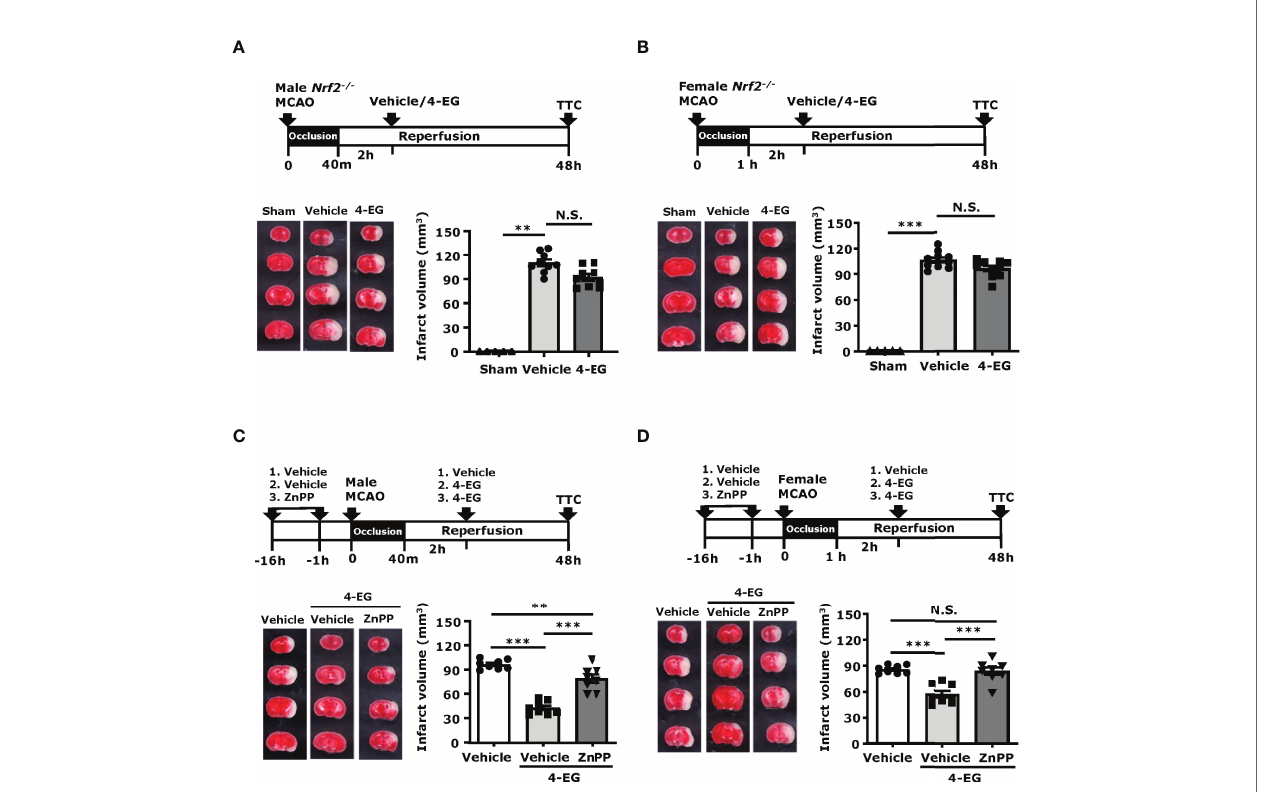
FIGURE 6 | Inhibition of Nrf2/HO-1 pathway reverses the protection effect of 4-EG in ischemic stroke. (A, B) Male and female Nrf2 − / − mice were subjected to sham or MCAO followed by vehicle or 4-EG (100 mg/kg) administration at 2 h post-reperfusion. At 48 h post-injury, mice were sacri fi ced, and the ischemic brains were harvested, sliced, and stained with TTC. (A) . The representative TTC-stained brain samples of sham, and vehicle- and 4-EG-treated male Nrf2 − / − MCAO mice are shown (left panel), and the infarct volumes of sham (n=5), and vehicle- and 4-EG-treated male Nrf2 − / − MCAO mice (n=9/group) were measured (right panel). ** p < 0.01 , N.S., no signi fi cant differences by the Kruskal – Wallis test. (B) The representative TTC-stained brain samples of sham, and vehicle- and 4-EG-treated female Nrf2 − / − MCAO mice are shown (left panel), and the infarct volumes of sham (n=5), and vehicle- and 4-EG-treated female Nrf2 − / − MCAO mice (n=10/group) were measured (right panel). *** p < 0.001 , N.S., no signi fi cant differences by the Kruskal – Wallis test. (C) Male and (D) female C57BL/6 mice were pretreated with either vehicle or ZnPP (30 mg/kg) overnight and 1 h prior to MCAO. At 2 h post-reperfusion, vehicle-treated MCAO mice were treated with vehicle or 4-EG, and ZnPP-treated MCAO mice were treated with 4-EG. At 48 h post-injury, mice were sacri fi ced, and ischemic brains were harvested and subjected to TTC staining. The representative TTC-stained brain samples are shown (left panel), and the infarct volumes of vehicle-, 4-EG-, and ZnPP+4-EG-treated MCAO (n=8/group) mice were measured (right panel). **p<0.01, ***p<0.001 , N.S., no signi fi cant differences by one-way